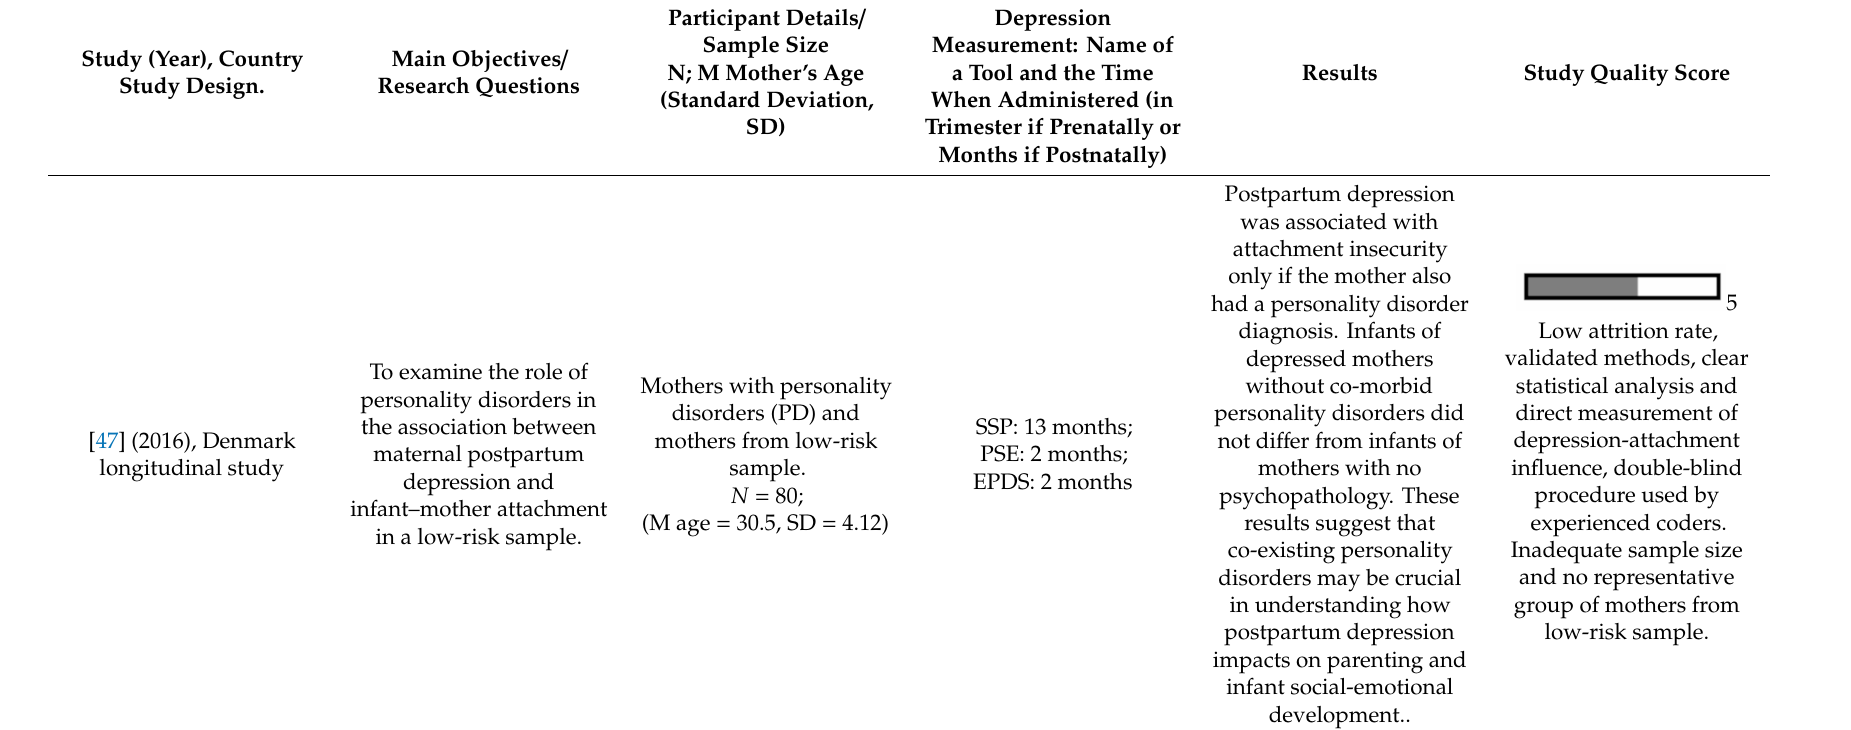
Study (Year), Country Study